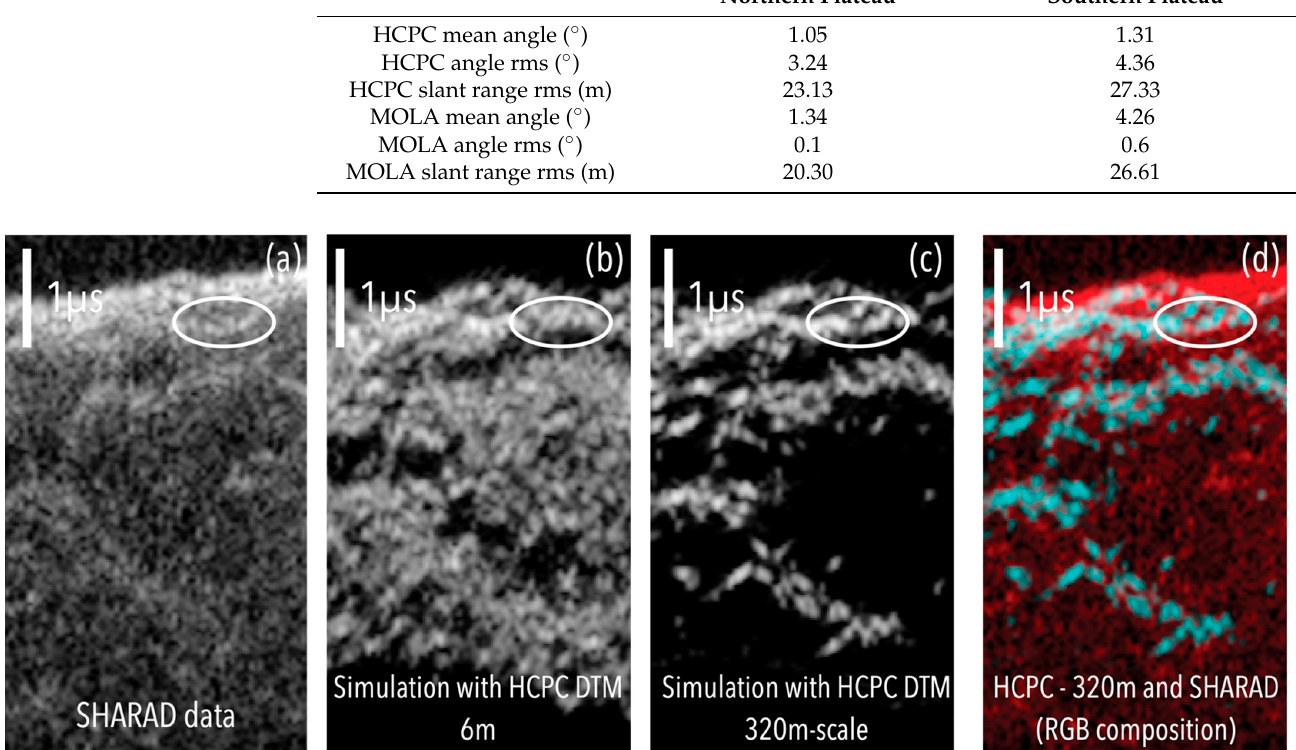
Table 3. Comparison of the mean and variance of the incidence angles for MOLA and HCPC DTMs, along with the variance in range on the northern and southern plateaus (see Figure 14 for the detailed outlines of the area). Northern Plateau Southern Plateau